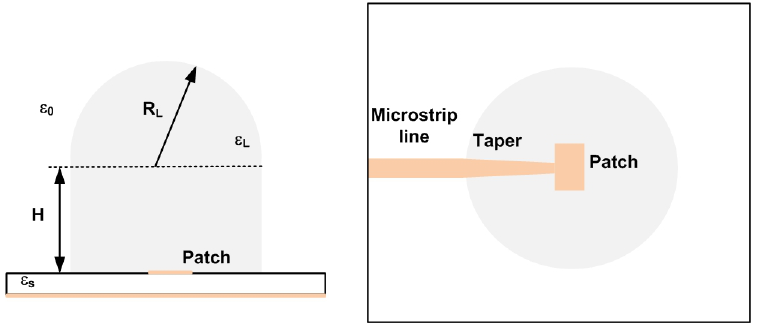
Figure 6. Detail of the dielectric lens antenna.